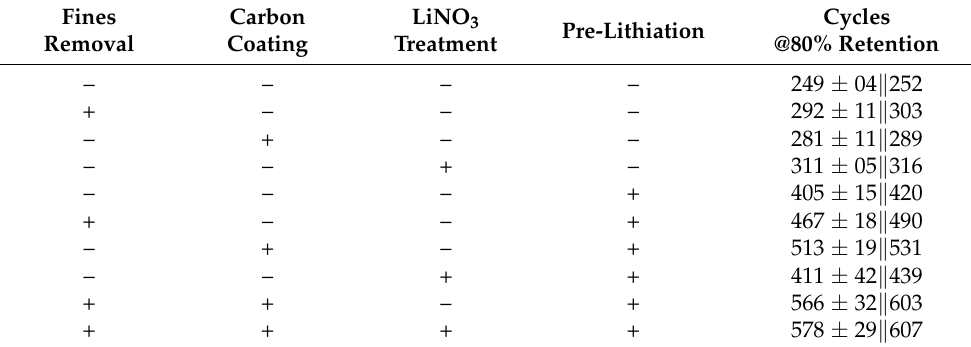
Table 3. Cycle stabilities for combinations of the different optimization approaches (all electrolytes with DEC/FEC, 4.2–3.0 V window). The combination of prelithiation with carbon coated, size reduced CLM00001 allows more than 600 cycles. The cycle numbers at 80% capacity retention are given as mean values with standard deviation for a series of three cells and as maximum